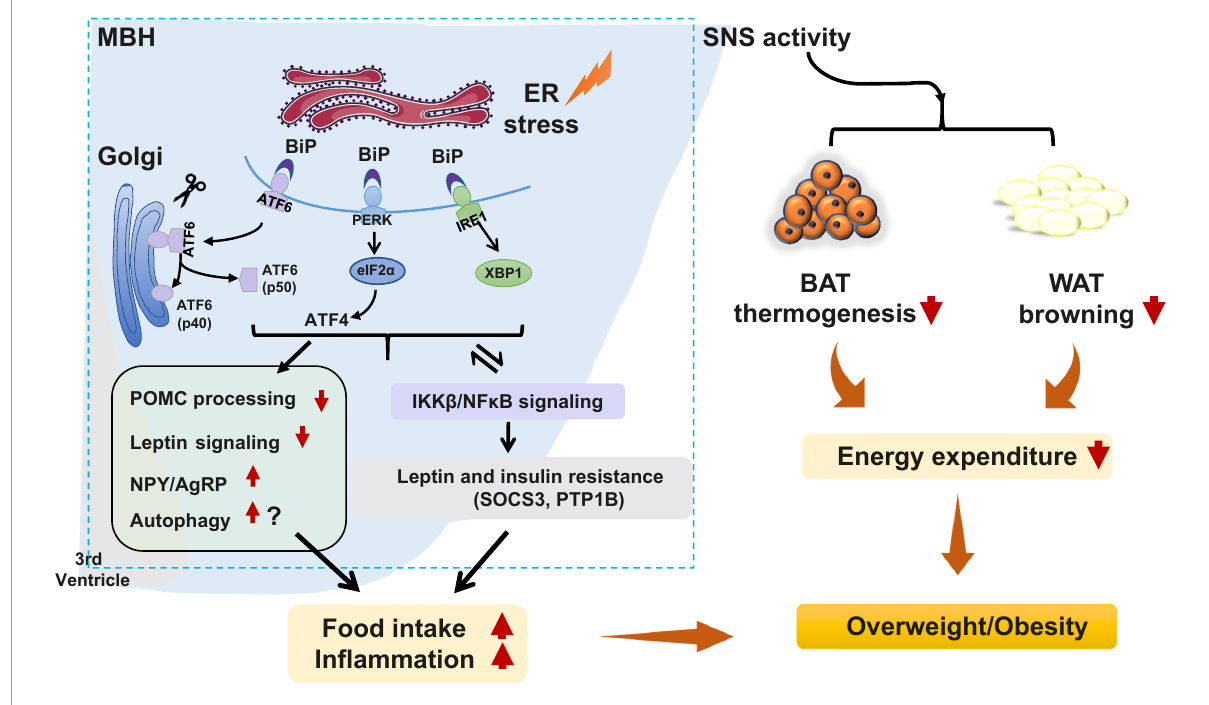
FIGURE1 Potential role of hypothalamic endoplasmic reticulum (ER) stress in obesity and inflammation. Under certain stimuli, such as high-fat diet (HFD) feeding, drug treatment, or infection, ER stress is activated, and binding immunoglobulin protein (BiP) dissociates from protein kinase R-like ER kinase (PERK), inositol requiring enzyme 1 (IRE1), and activating transcription factor 6 (ATF6), resulting in the release of those three proteins. PERK is then activated by phosphorylation and p-PERK phosphorylates eukaryotic initiation factor 2 α (eIF2 α ) and increases the translation of ATF4. ATF6 relocates to the Golgi apparatus and is processed by site 1 and 2 proteases, resulting in ATF6 activation. IRE1 is activated by phosphorylation. pIRE1 catalyzes X-box-binding protein 1 (XBP1) mRNA splicing, resulting in increased production of active spliced XBP1. These effects could (1) activate the hypothalamic autophagy signaling, impede proopiomelanocortin (POMC) processing, attenuate leptin signaling, and possibly increase neuropeptide Y (NPY), and agouti-related peptide (AgRP) expression, leading to increased food intake, decreased energy expenditure, inflammation, and weight gain; (2) decrease white adipose tissue (WAT) browning and brown adipose tissue (BAT) thermogenesis by affecting sympathetic nervous system (SNS) activity, resulting in lower energy expenditure and weight gain; and (3) trigger activation of